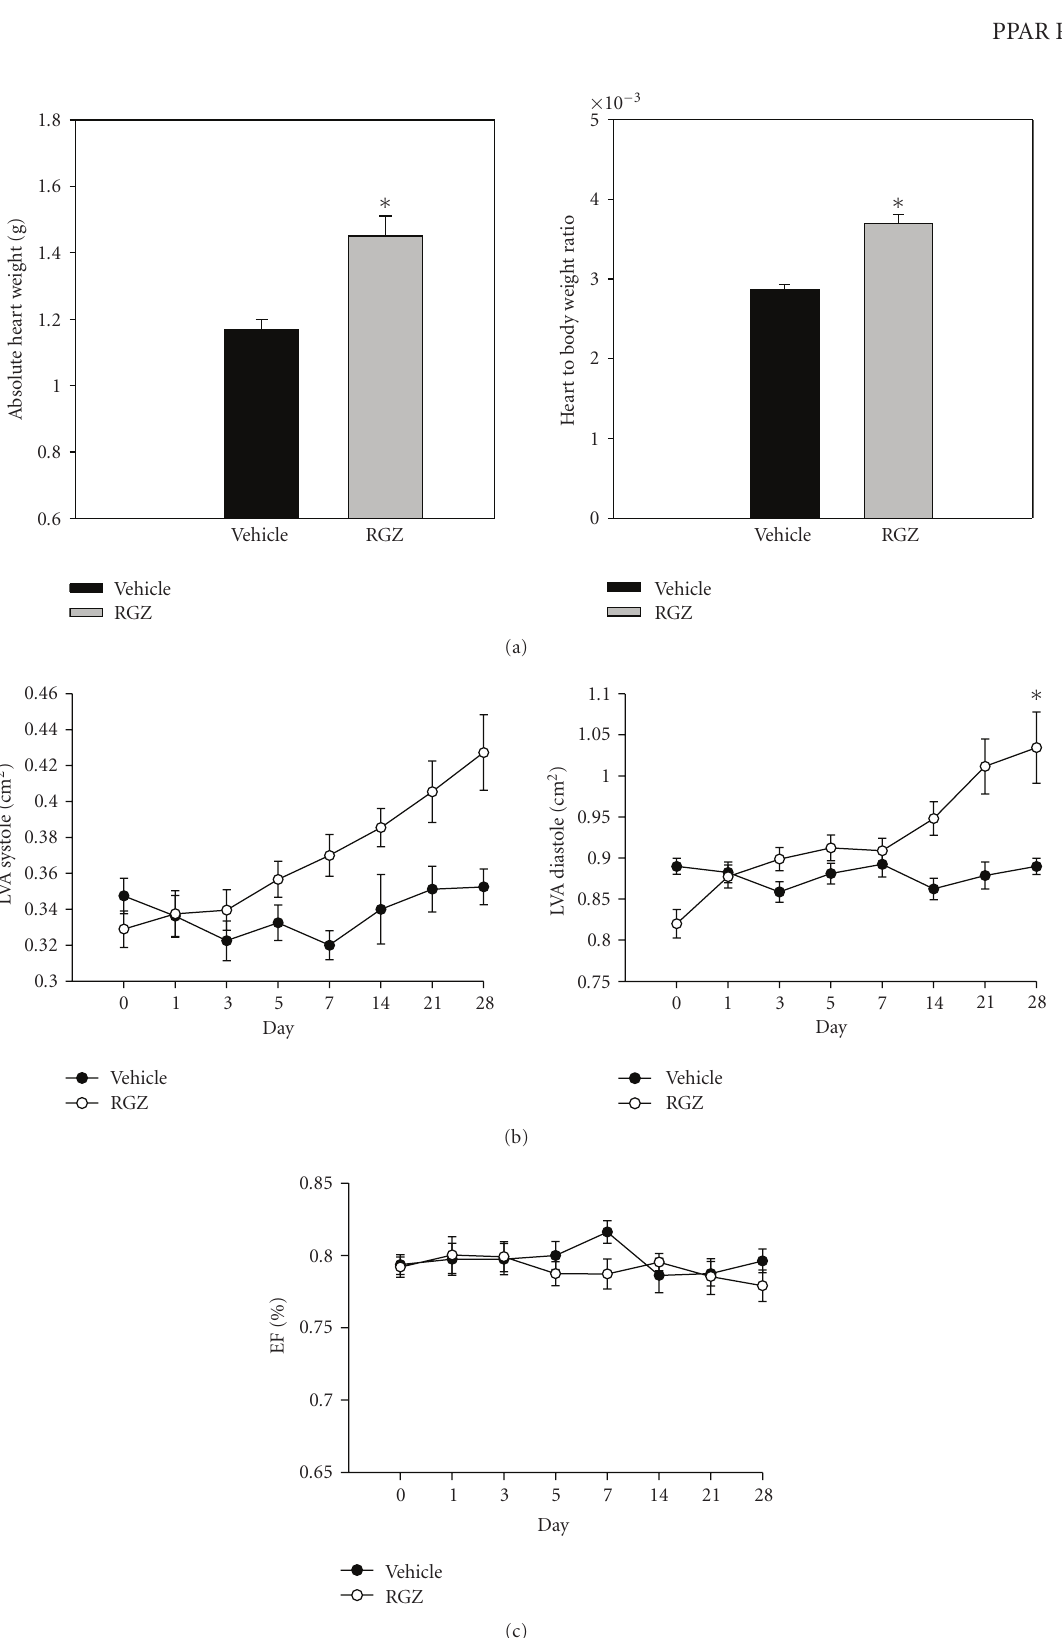
Figure 9: (a) Absolute heart weight and heart-to-body-weight ratio; (b) Left ventricular area (LVA) in systole and diastole; and (c) Ejection fraction (EFA) in normal male SD rats chronically treated with vehicle (VEH) or rosiglitazone at the dose of 80 mg/kg · body weight (RGZ), ( n = 10/treatment group). Data were represented as means ± SEM. Means were compared using unpaired t -test. ∗ indicates a significant di ff erence between the groups ( p < 0 .